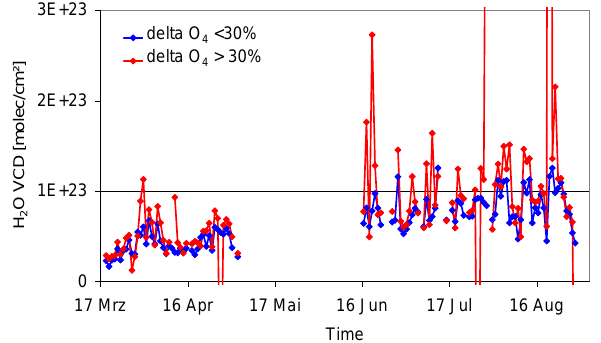
Fig. 7 Daily averaged H 2 O VCDs derived from MAX-DOAS observations. Blue symbols indicate measurements which fulfil the O 4 criterion; red symbols indicate measurements which do not fulfil the O 4 criterion (see text).